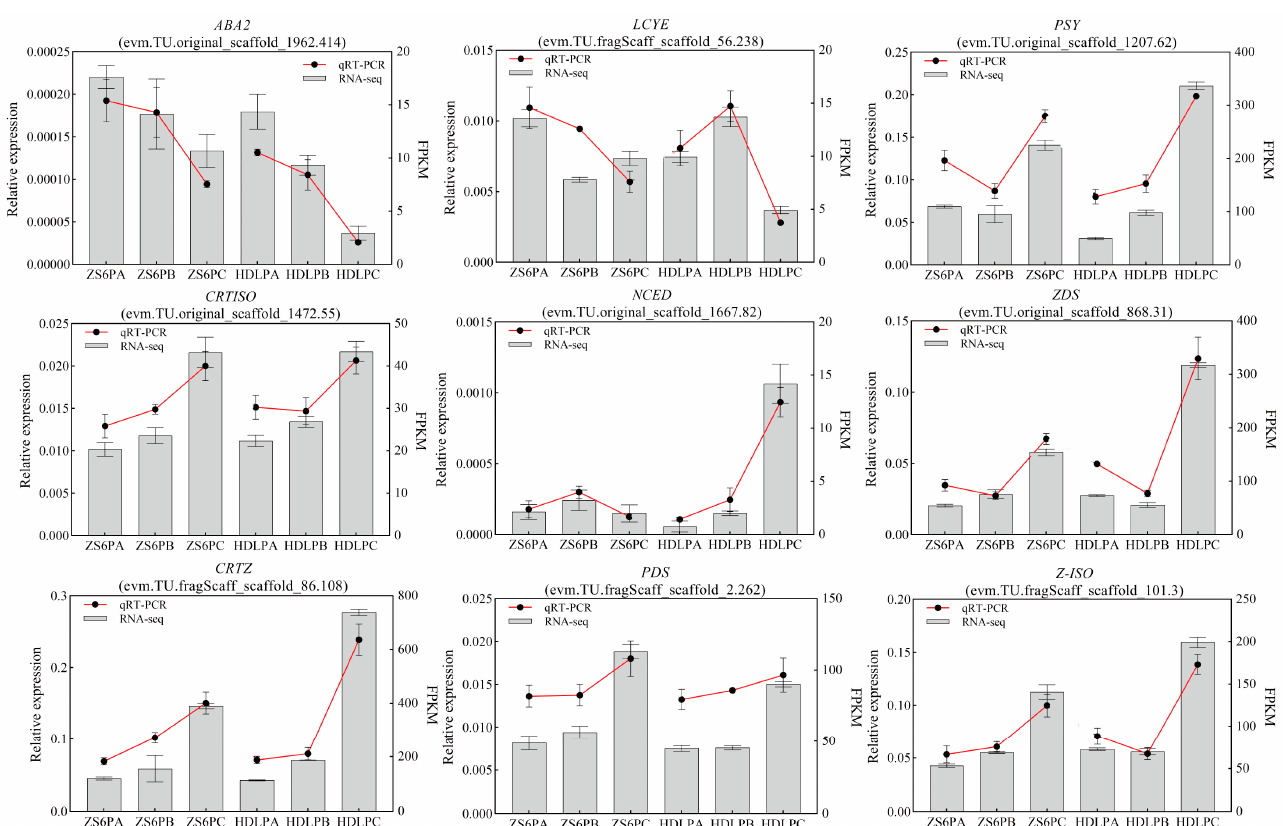
Figure 8. FPKM values and relative expression of nine candidate genes in two persimmon cultivars at three stages. The data represent the average of three biological replicates, and error bars reflect the standard deviation.